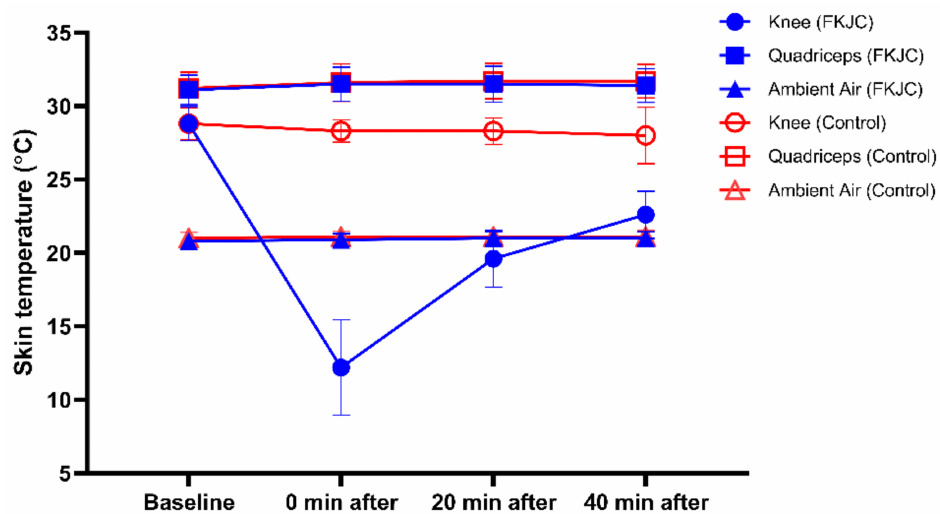
Figure 3. Skin temperature of the knee and quadriceps over a 40-min period following FKJC (blue) and control (red) conditions. FKJC, focal knee joint